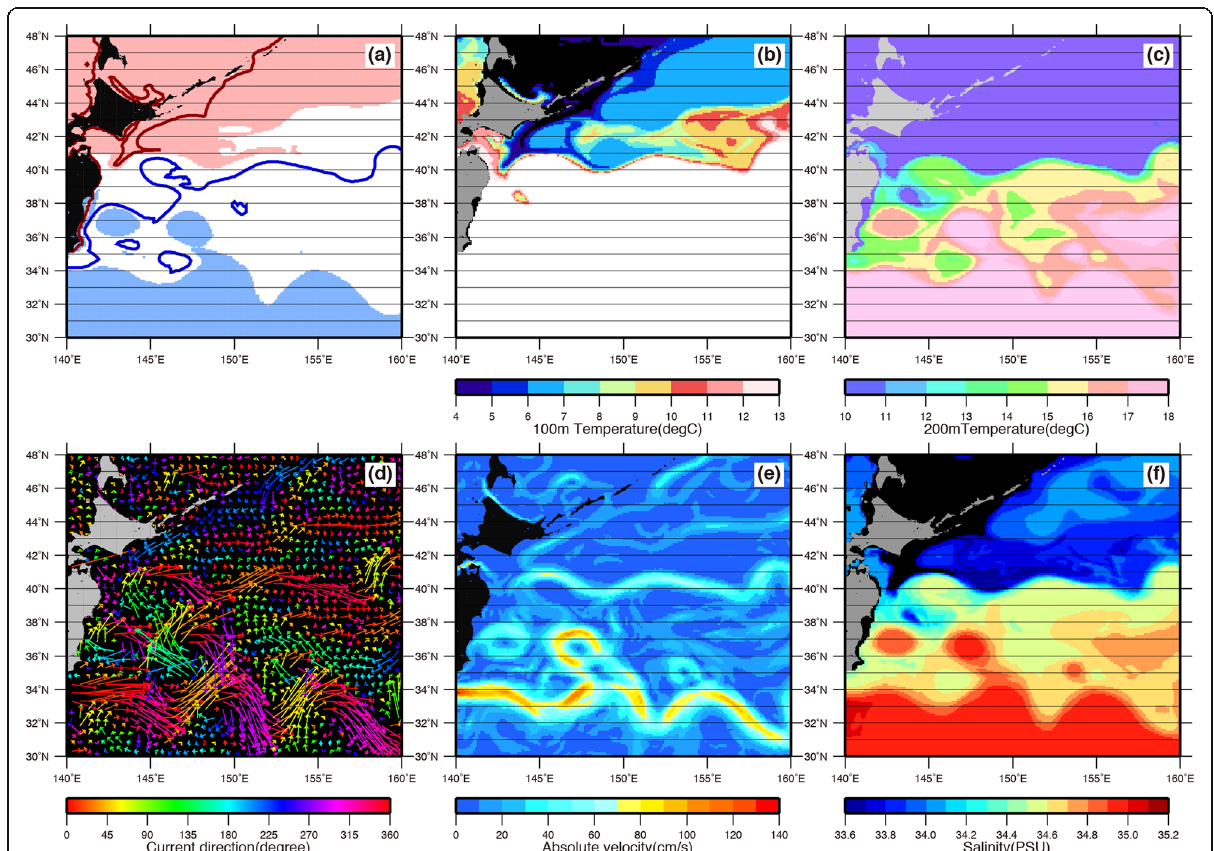
Fig. 8 a Distribution of the TS based Oyashio water (red shade) and TS-based Kuroshio water (blue shade) in May 2080 from RCP8.5 scenario of MIROC5. The isotherm of 5 °C represents the temperature-based Oyashio front and the isotherm of 14.5 °C represents the temperature-based Kuroshio front. b 100 m and c 200 m temperature distribution. d Surface current vector. Color represents current direction. e Surface absolute velocity. f 200 m salinity